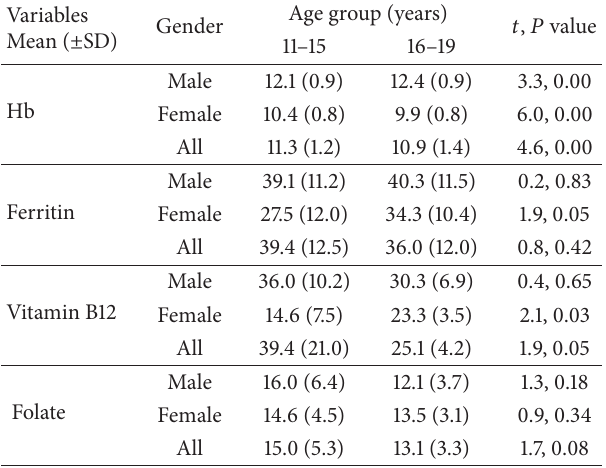
Table 1: Age and gender distribution of average Hb, ferritin, vitamin B12, and folate levels among studied adolescent males and females in Himalayan state of north India, 2010.